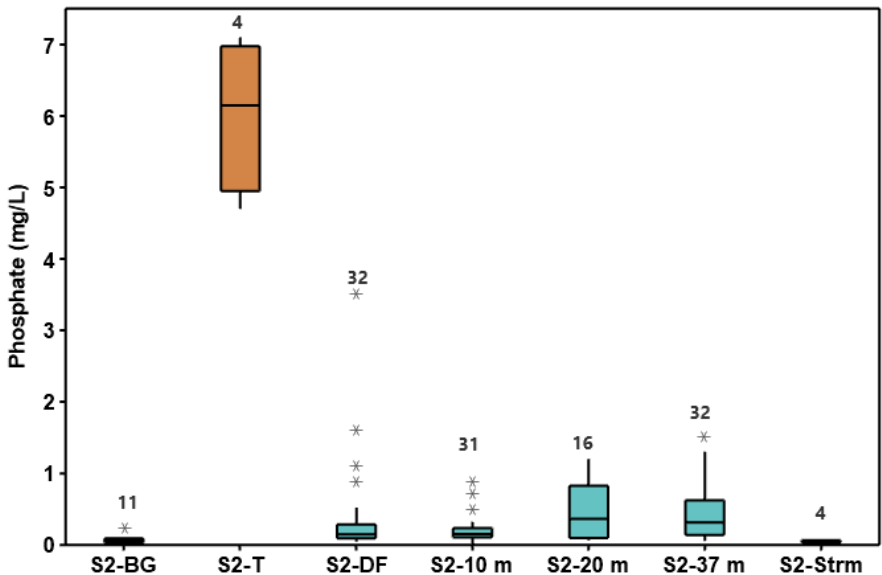
Figure 7. Phosphate concentrations in wastewater sampled from the septic tank (T), groundwater near the drainfield trenches (DF), groundwater 10 to 37 m downgradient from the trenches, in background groundwater (BG), and the adjacent stream at Site 2 (S2). Vertical lines extending from the boxes show minimum and maximum values. Statistical outliers are shown as (*). Number of samples is shown above each